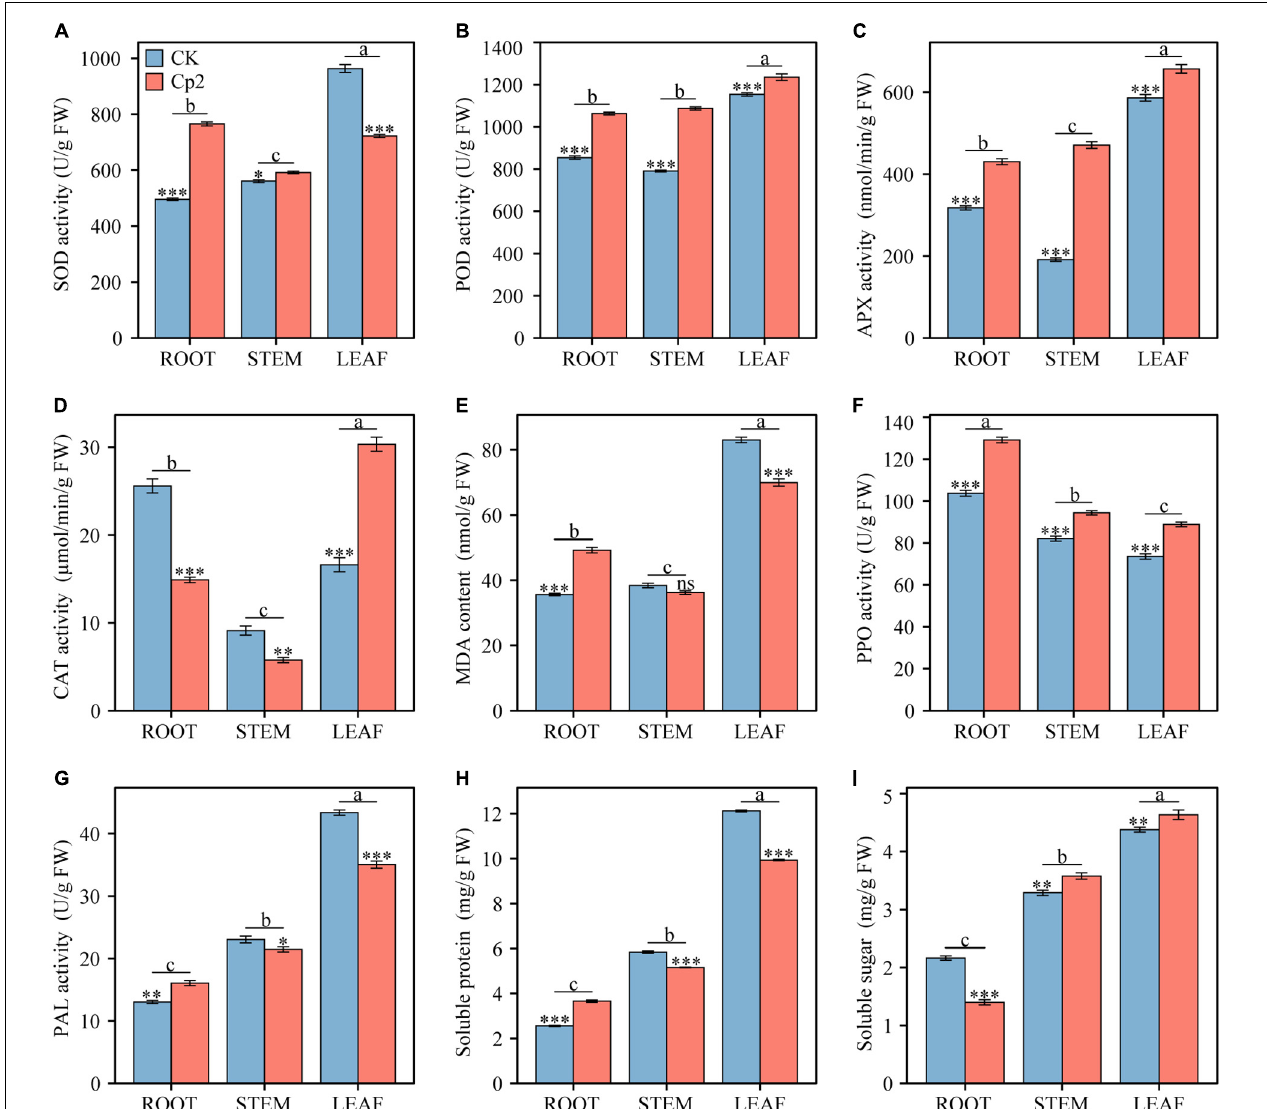
FIGURE 9 | Comparison of nine physiological indicators between different treatments and different plant tissues after 21 days of inoculation with E. persicina Cp2. (A) superoxide dismutase (SOD) activity. (B) peroxidease (POD) activity. (C) ascorbate peroxidase (APX) activity. (D) catalase (CAT) activity. (E) malondialdehyde (MDA) content. (F) polyphenol oxidase (PPO) activity. (G) phenylalanine ammonia lyase (PAL) activity. (H) soluble protein. (I) soluble sugar. FW, fresh weight. Two-way ANOVA test, Bonferroni post test. CK versus Cp2: ns: P ≥ 0.05, * P < 0.05, ** P < 0.01, *** P < 0.001; root versus stem versus leaf: a–c, P < 0.01. n = 3; mean ± SE.